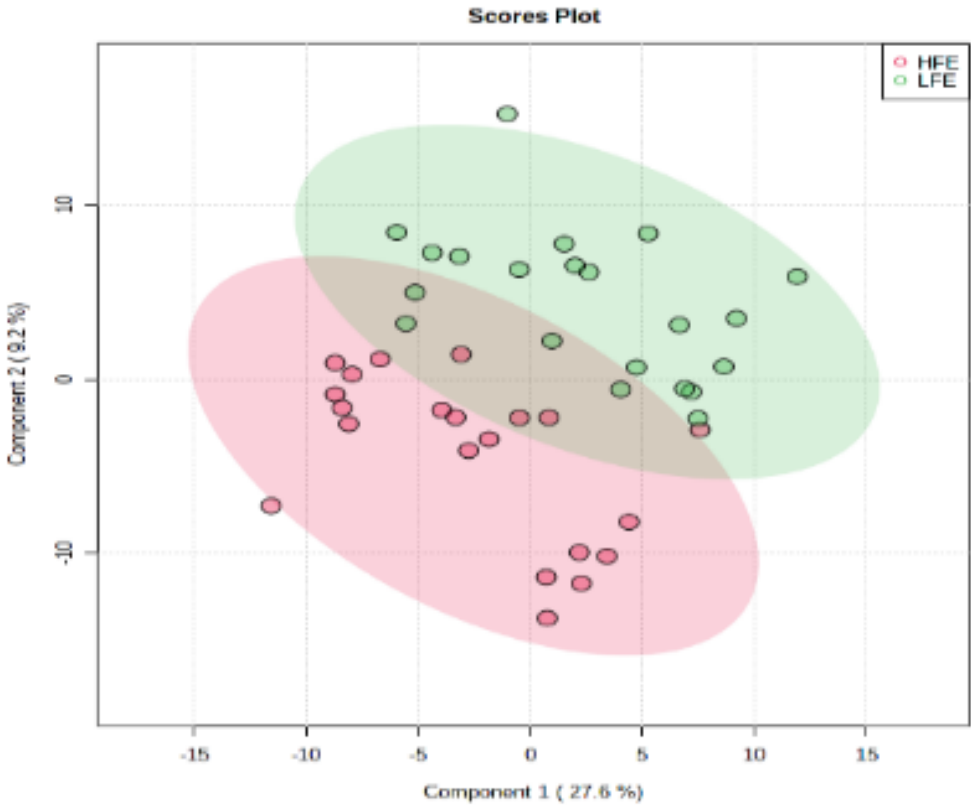
Figure 1. PLS-DA scores plot of rumen metabolome of LFE and HFE steers. HFE = beef steers with negative residual feed intake; LFE = beef steers with positive residual feed intake.